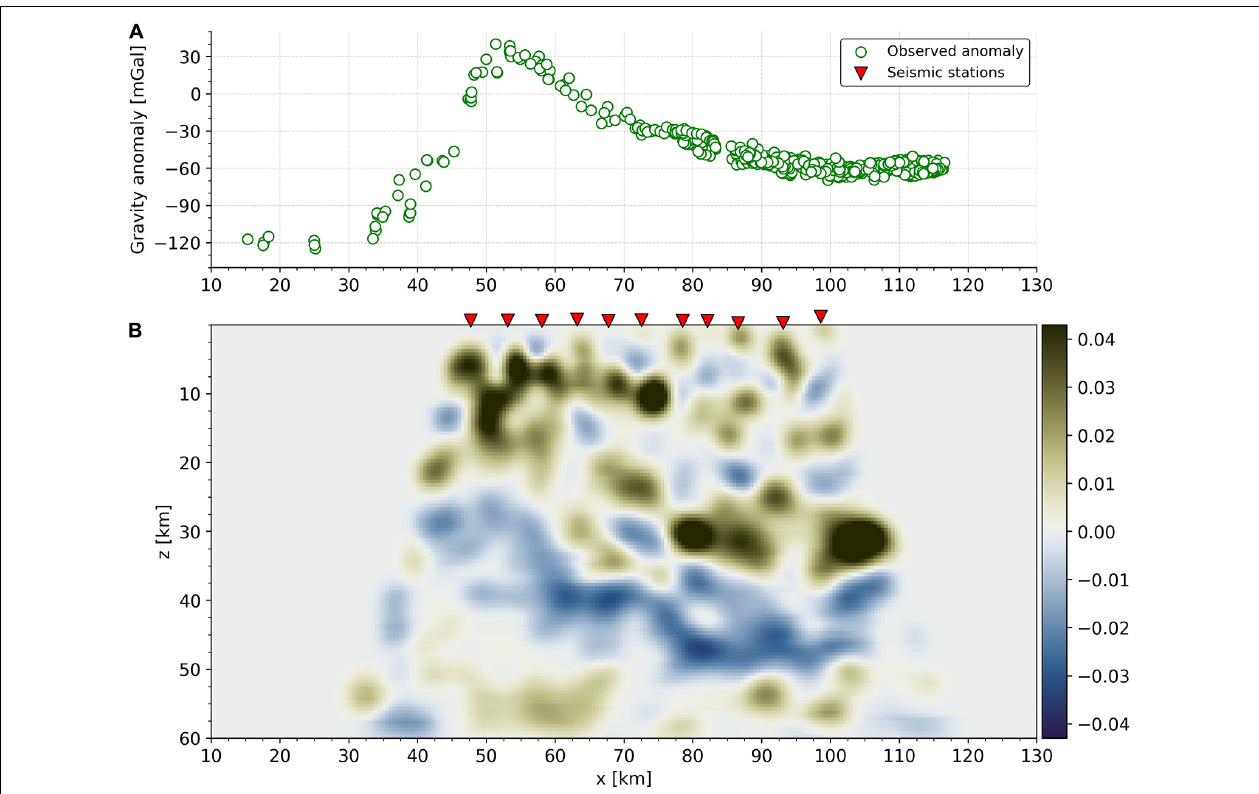
FIGURE 3 | (A) Niggli gravity anomaly computed from observed data and applying rock-density-based terrain corrections (Scarponi et al., 2020) along the West-East IvreaArray profile. (B) An example of migrated receiver function profile with the use of the IvreaArray and VARE seismic data and the iasp91 velocity model for ray-tracing and migration. Colors highlight areas of increasing (brown) and decreasing (blue) seismic velocities with